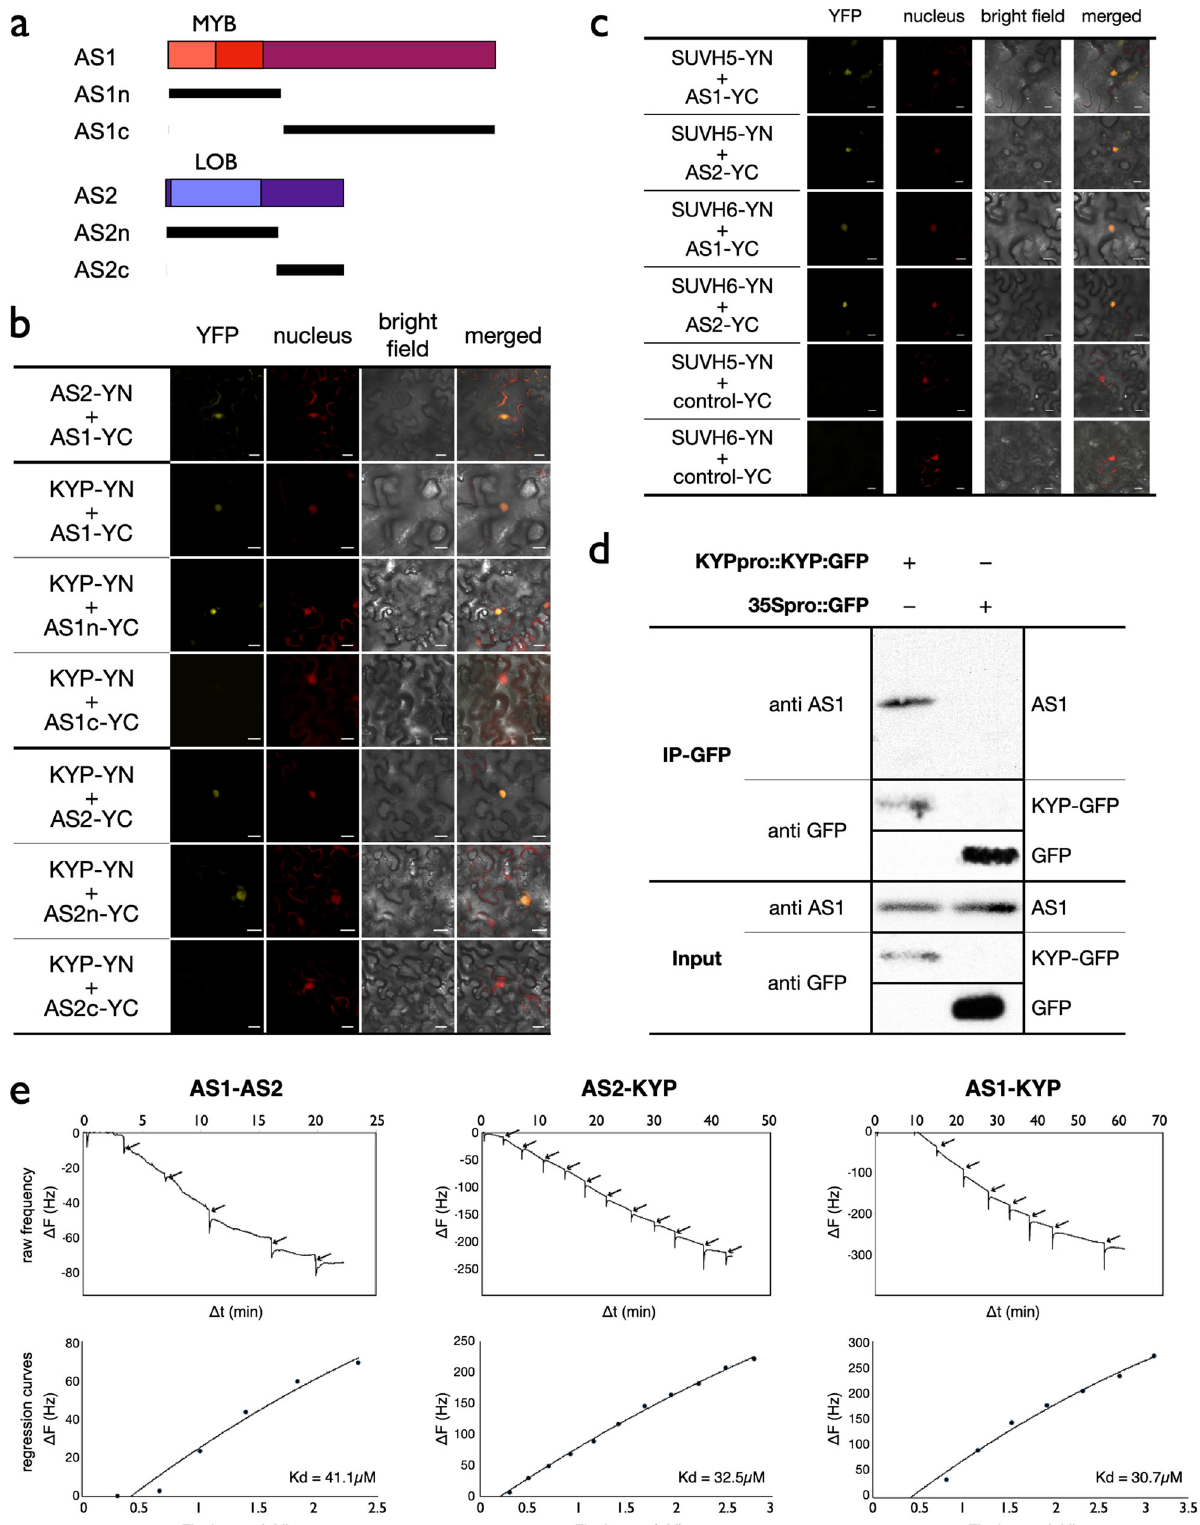
HDA6 regulate KNAT1 / 2 expression through H3K9me2 and H3 deacetylation. Interestingly, we found that the H3K9me2 level of KNAT1 / 2 was not decreased in hda6 (Fig. 3c). Furthermore, the H3Ac level of KNAT1 / 2 was not signi fi cantly changed in kyp and kyp/suvh5/6 (Fig. 3d). The expression of KNAT1 / 2 was highest in the hda6/kyp/suvh5/6 quadruple mutant (Fig. 3a), indicating